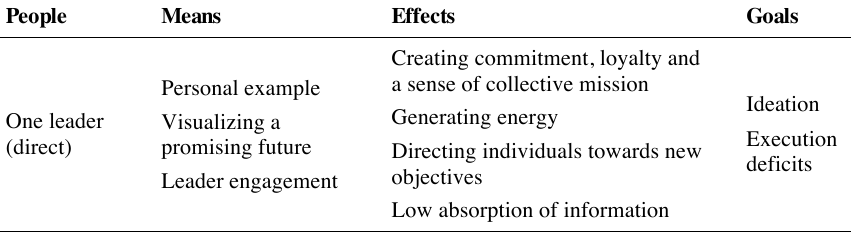
Ideation Execution